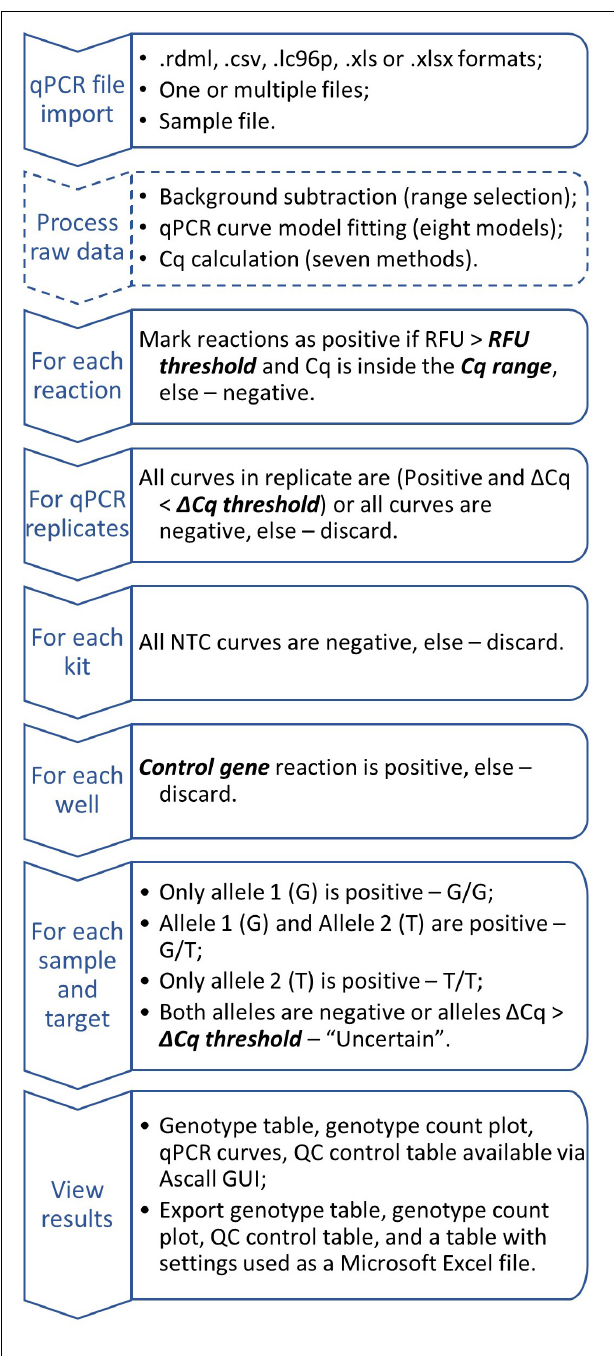
FIGURE 4 | Generalized AScall analysis workflow. Optional steps dashed, user-controlled parameters are in bold